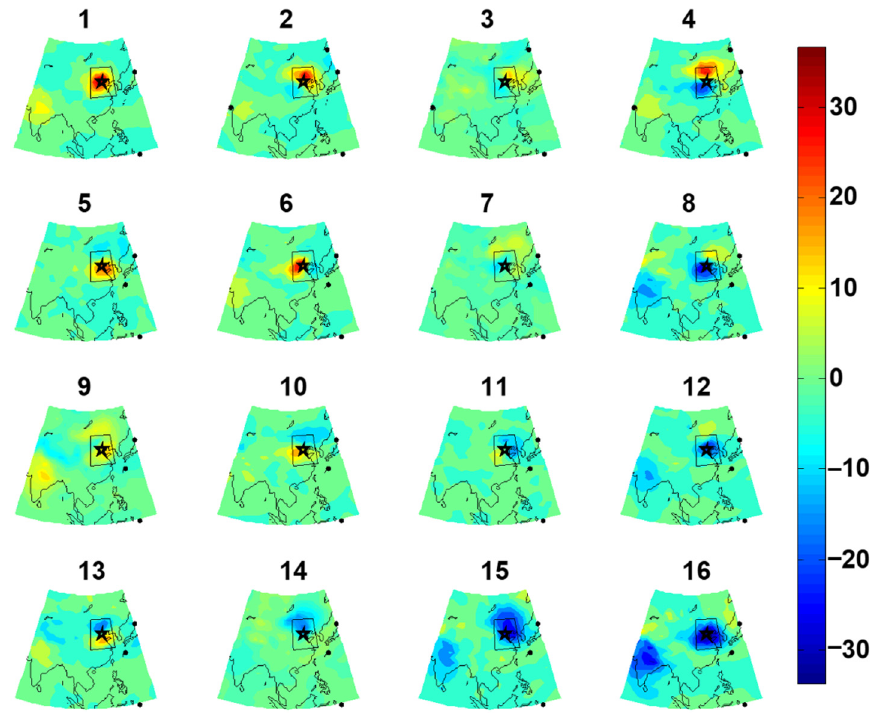
Figure 7. Distribution of 850 hPa relative humidity field (%) for the 16 SOM nodes corresponding to the training results.